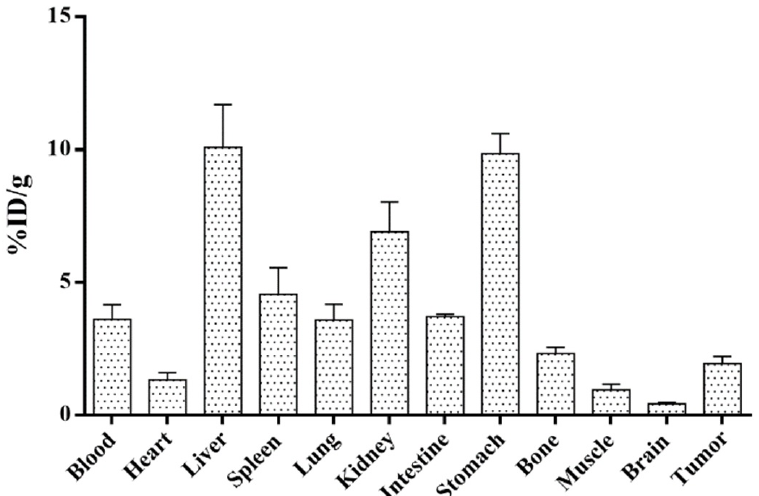
Figure 4. Biodistribution of 131 I-Sgc8-P was measured by gamma counting in mice. The mice were sacrificed at 0.5 h post-injection and organs were harvested and counted.